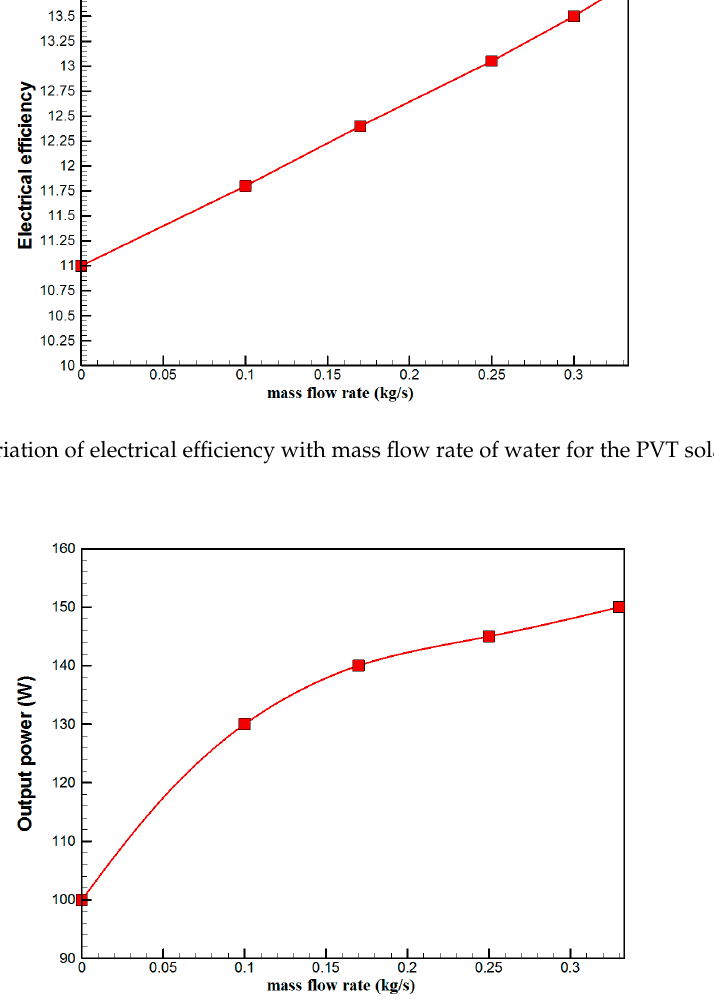
Figure 17. The variation of power output with mass flow rate of water for the PVT solar collector with CPC.